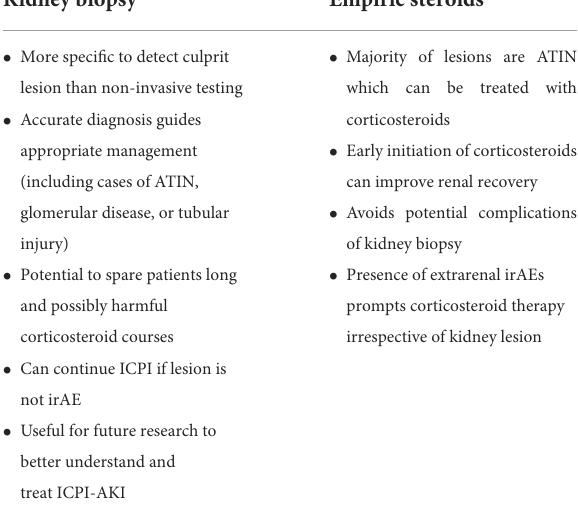
TABLE 1 Pro and con arguments for kidney biopsy in ICPI-AKI. Kidney biopsy Empiric